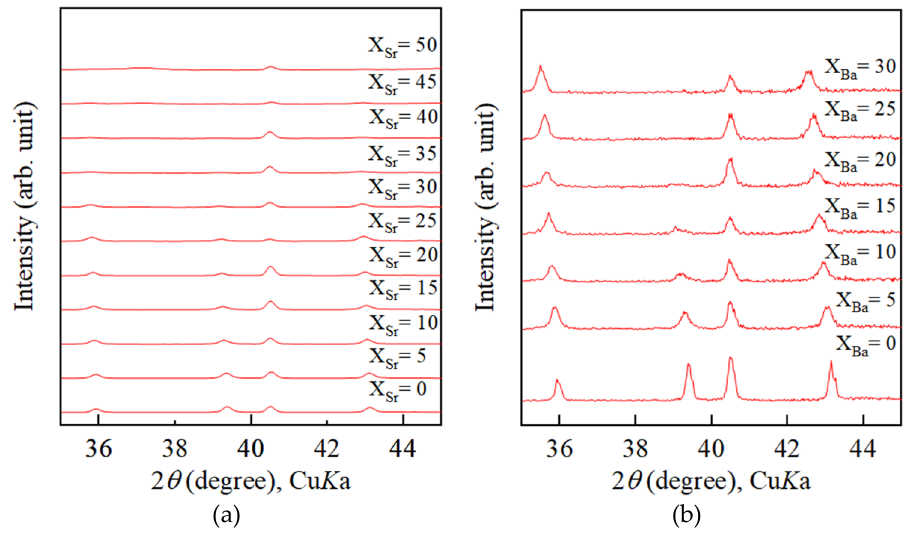
Figure 6. Disappearance of 113 reflection observed from powder X-ray patterns of ( a ) Sr-doped calcite samples and ( b ) Ba-doped calcite samples.